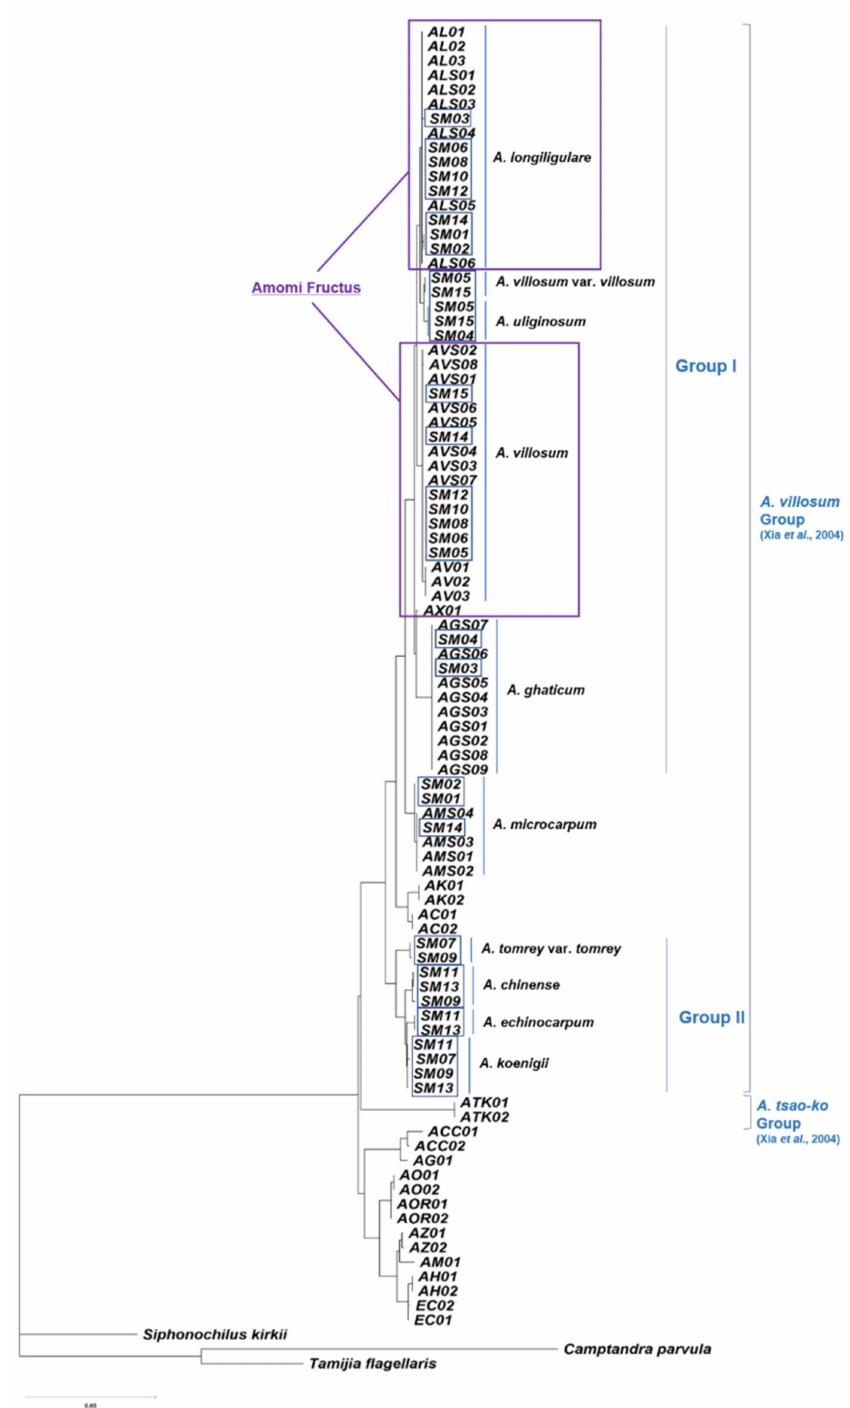
Figure 1. Maximum likelihood-based inference of phylogenetic tree with smart model selection constructed based on concatenated nucleotide sequences of an ITS (internal transcribed spacer) and four chloroplast genome-based DNA barcode regions. AX01: Amomum villosum var. xanthioides nucleotide sequence of KJ151892 and MH161417. The box indicates the species-mixed